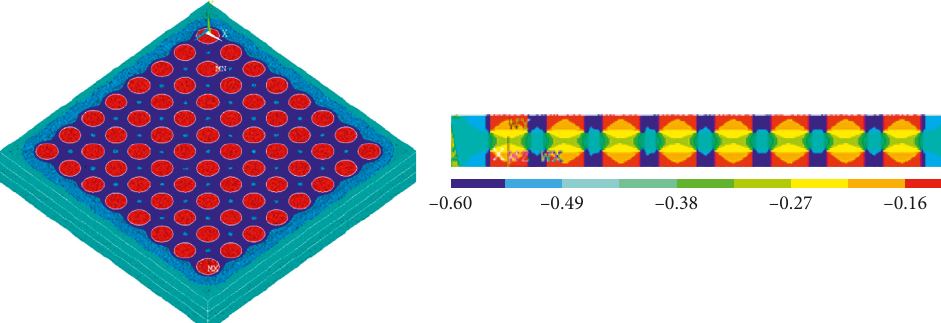
Figure 27: Overall heat flux density distribution diagram (J/(m 2